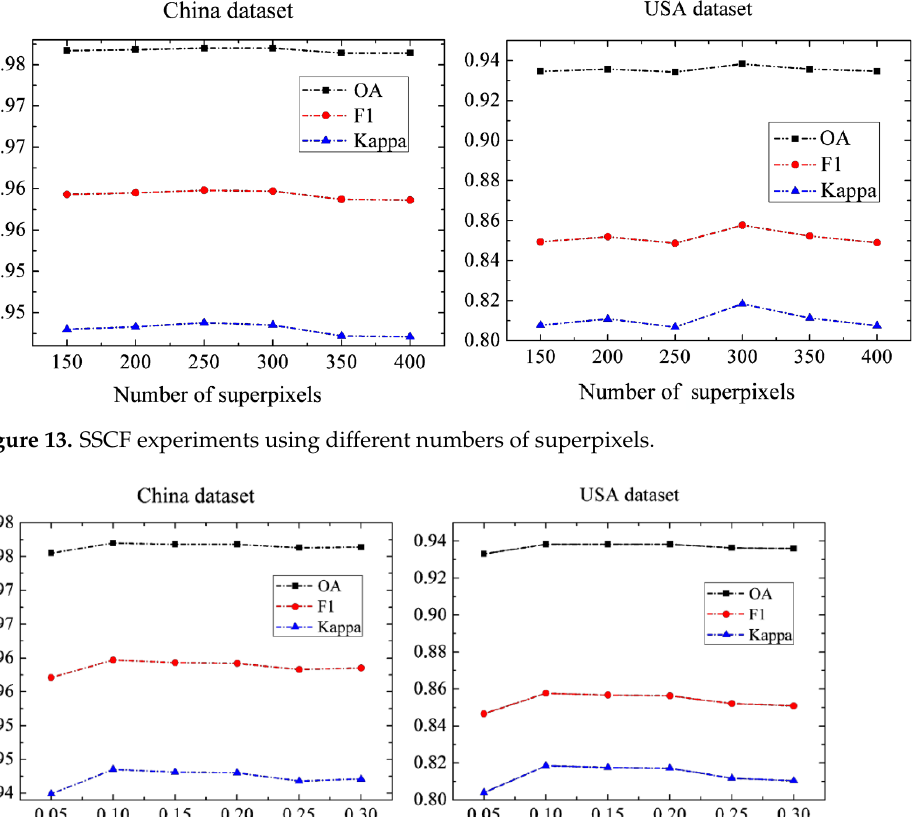
Figure 14. SSCF experiments using different proportions of uncertain pixels.